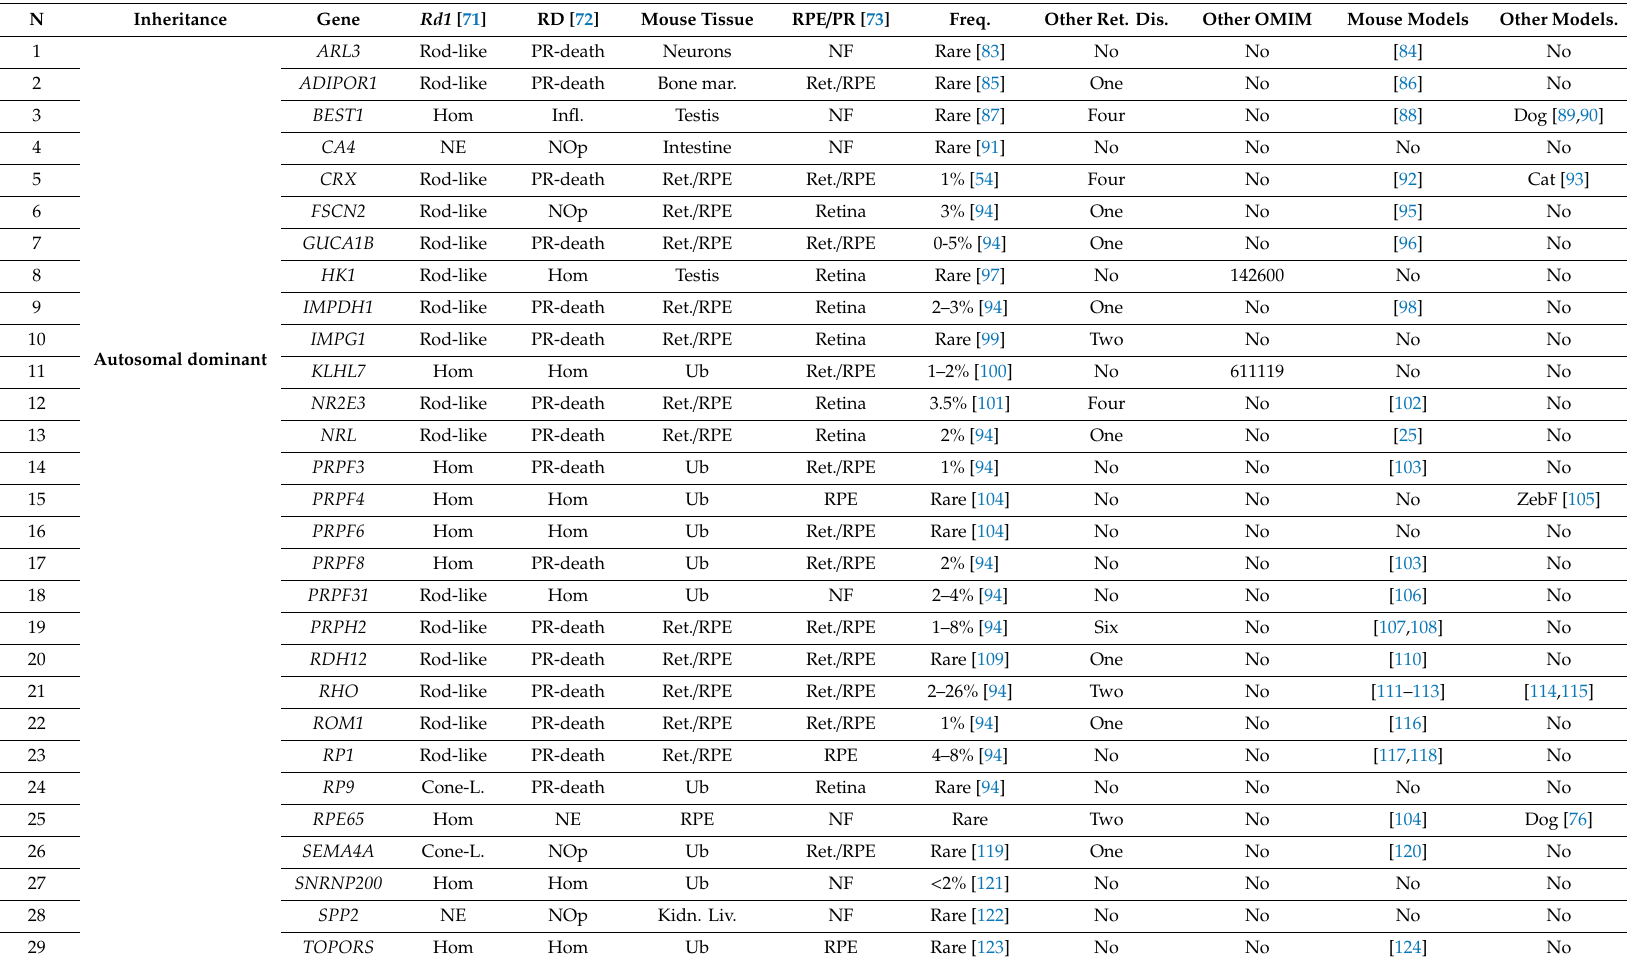
Table 1. The expression of genes mutated in retinitis